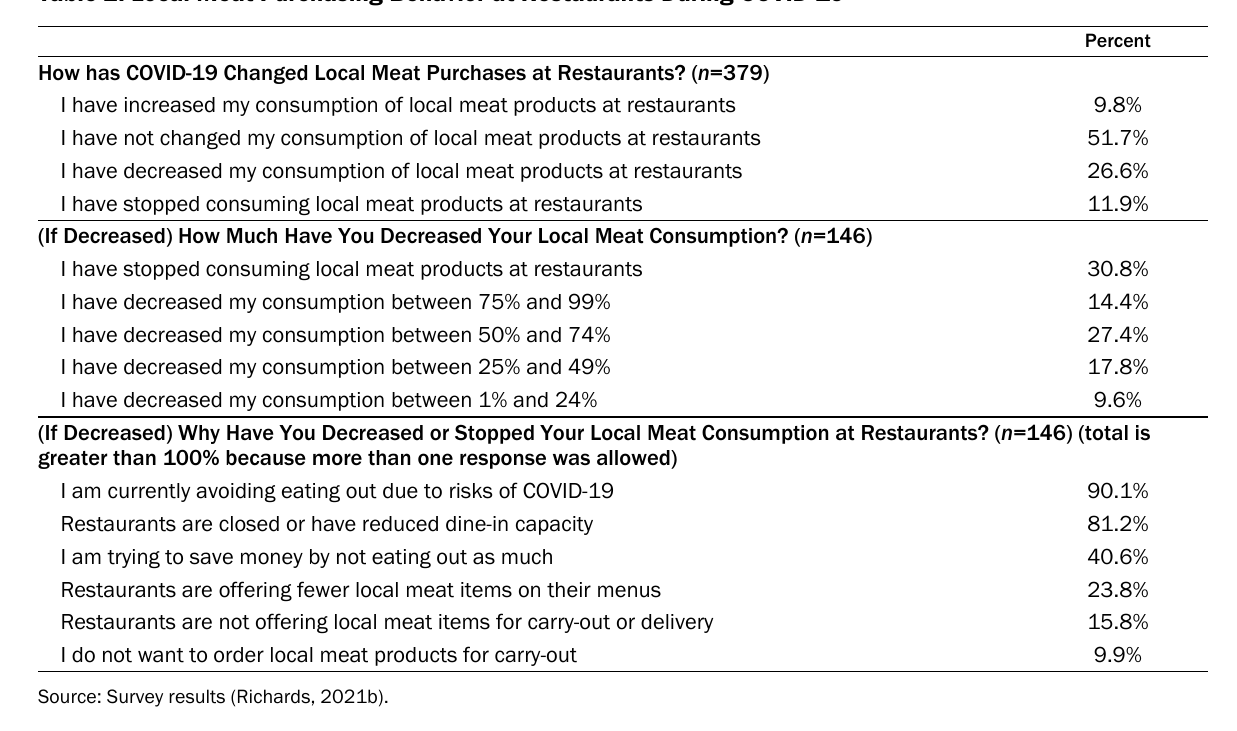
Table 2. Local Meat Purchasing Behavior at Restaurants During COVID-19